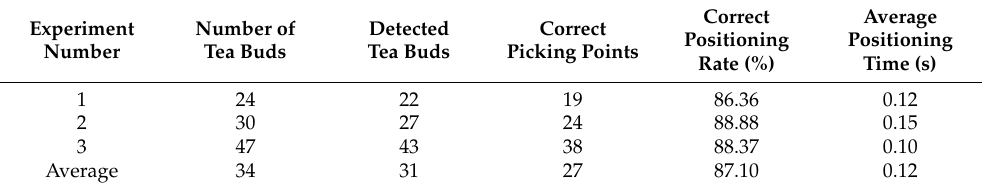
Figure 14. Picking points localized in the original RGB image. Table 5. Results of picking point positioning test.